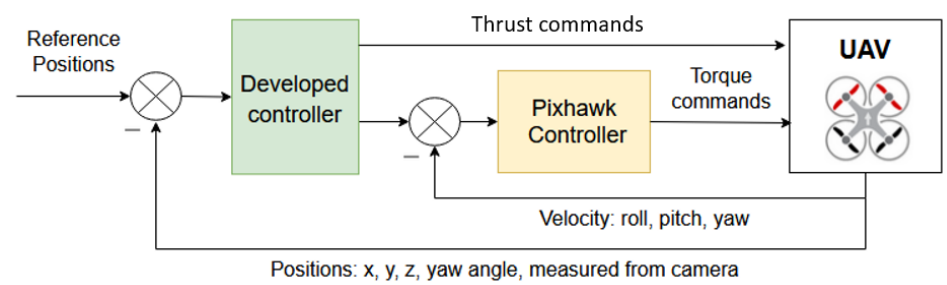
Figure 3. UAV system control